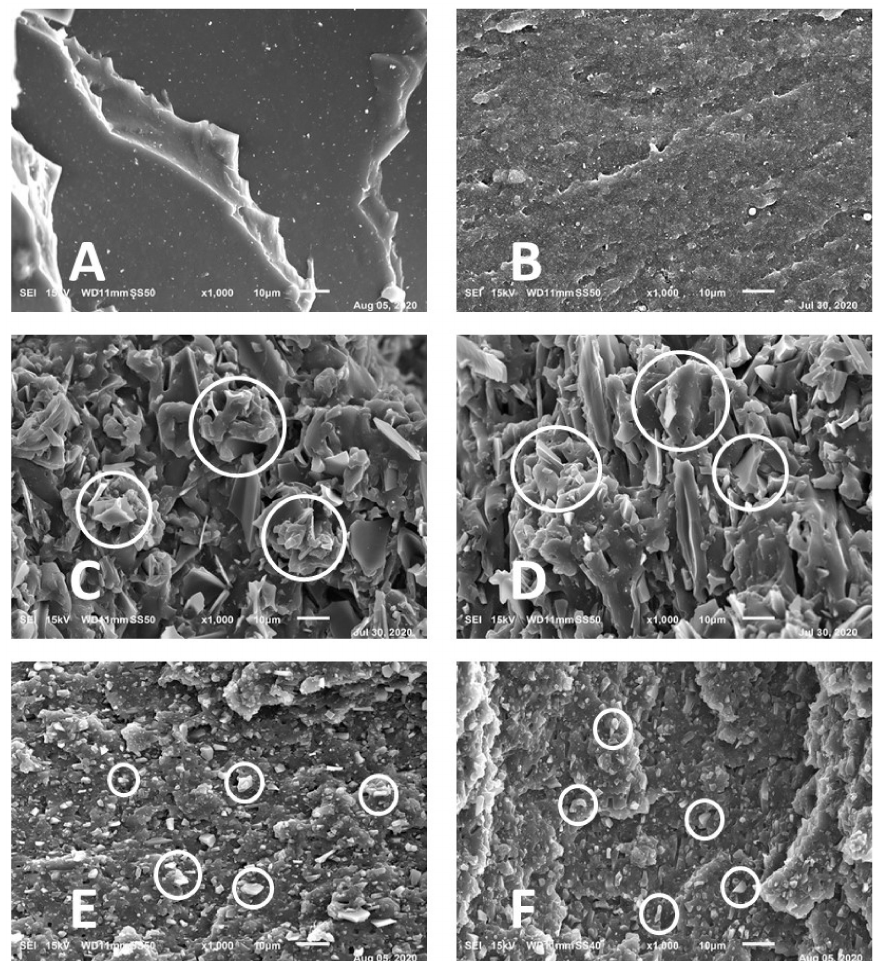
Figure 2. ( A ) Unfilled BR-NR rubber matrix. ( B ) 100% CB filled control. ( C ) 100% PAUL filled, no silica milling. ( D ) 100% POP filled, no silica milling. ( E ) 100% PAUL filled, after silica milling. ( F ) 100% POP filled, after silica milling. In each image the white scale bar at the lower right corner represents 10 microns. A few biochar particles have been circled to illustrate the size reduction that takes place during silica